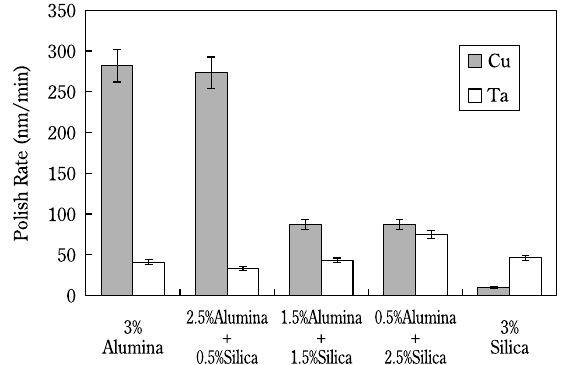
Fig. 4.1: Copper and tantalum disk polish rates by slurries containing alumina/fumed silica particles dispersed in DI water at pH 4 with 3 wt % total particle loading (Reprinted from reference 34; Reproduced by permission of ECS ― The Electrochemical